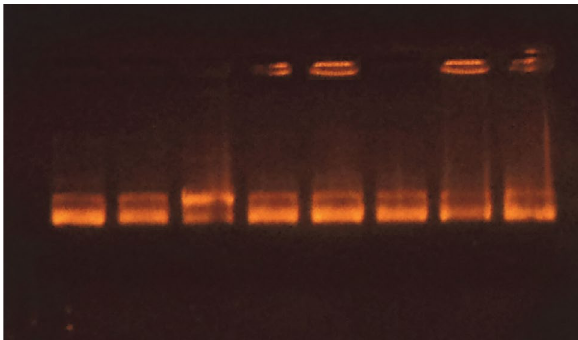
Fig. 4: DNA cleavage analysis. 1st well- Control only pBR322; 2nd well- pBR322+H 2 O 2 and Buffer; 3rd well- Sample (MnL)-10 µg; 4th well- Sample (MnL)-20 µg; 5th well-sample (MnL)-30 µg; 6th well- sample (FeL)-10 µg; 7th well- sample (FeL)-20 µg; 8th well- sample (FeL)-30 µg